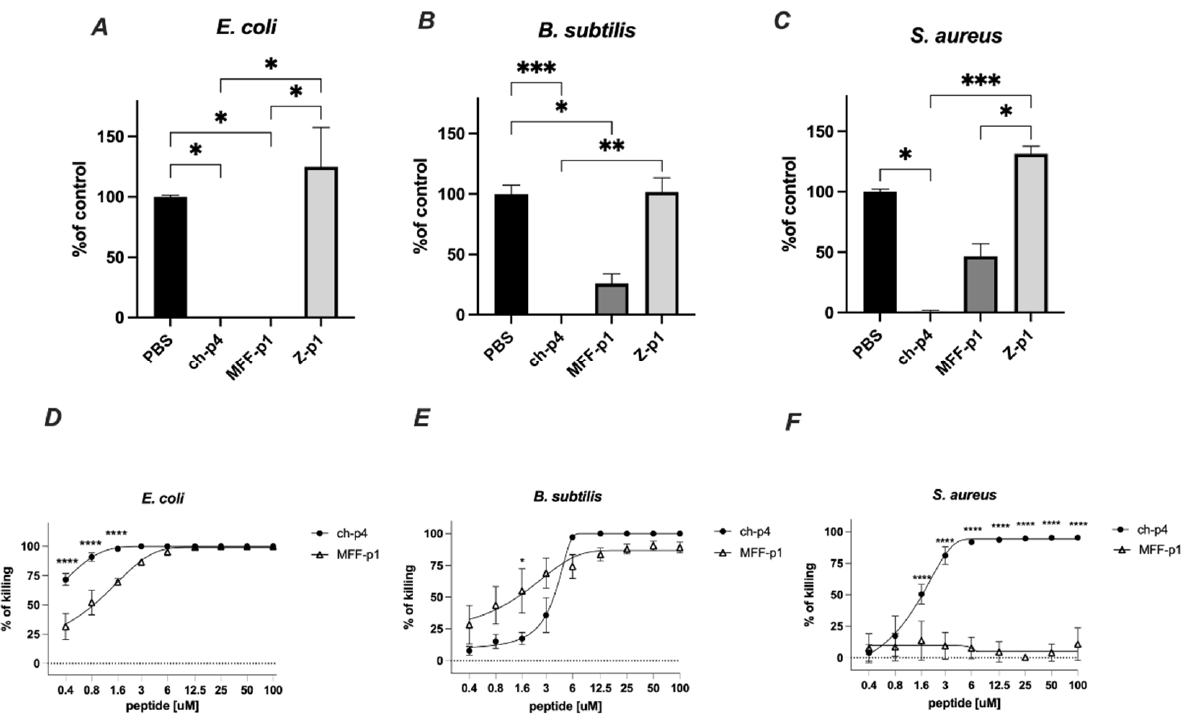
Figure 4. MFF-p1 is bactericidal in vitro. ( A – C ): E. coli (HB101 strain), B. subtilis (ATCC 9372 strain), and S. aureus (8325-4 strain) were incubated with chemerin-p4, MFF-p1 and Z-p1 (100 µ M) peptides for 2 h. Cell viability was analyzed by MDA assay. N = 3, mean ± SEM, ***, and p < 0.001; **, p < 0.01; and *, p < 0.05 by Kruskal–Wallis one-way ANOVA with post hoc Dunn’s test. ( D – F ): Bacteria were incubated with chemerin-p4 or MFF-p1 peptides at the indicated concentrations for 2 h. Data show the percentage of killing (0%—control group). Mean ± SEM of three independent measurements is shown. ****, p < 0.0001; *, p < 0.05 by one-way ANOVA with post hoc Sidak test.